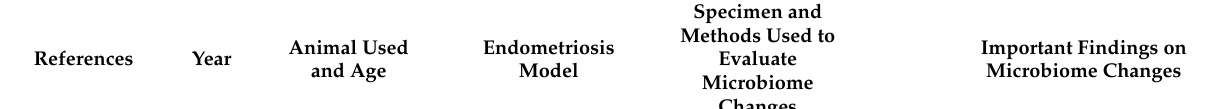
Table 4. Studies reporting microbiome changes in animal models of